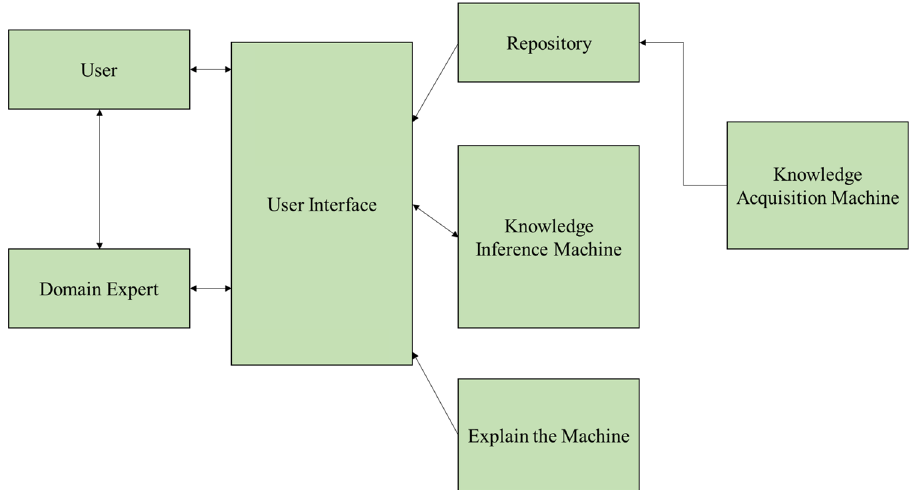
Figure 3: Structure of the DCAS.